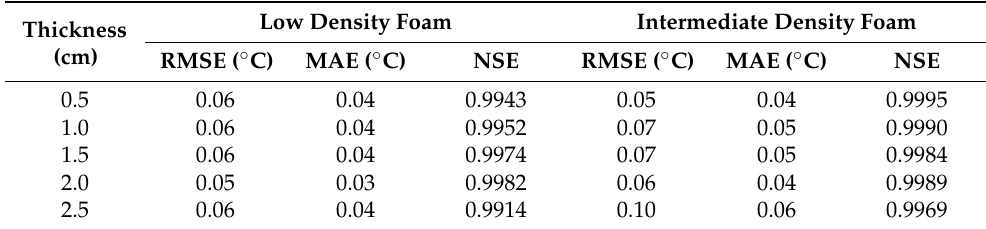
Table 2. Evaluation of the data driven ANN-based